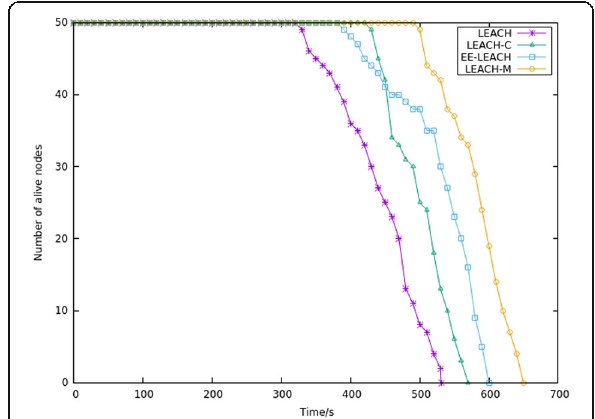
Fig. 4 The comparison of alive nodes for LEACH, LEACH-C, EE-